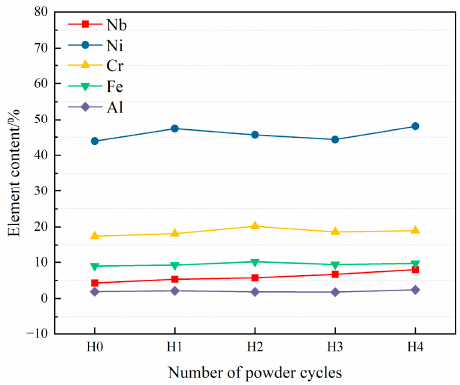
Figure 6. Elemental content of recycled powder.